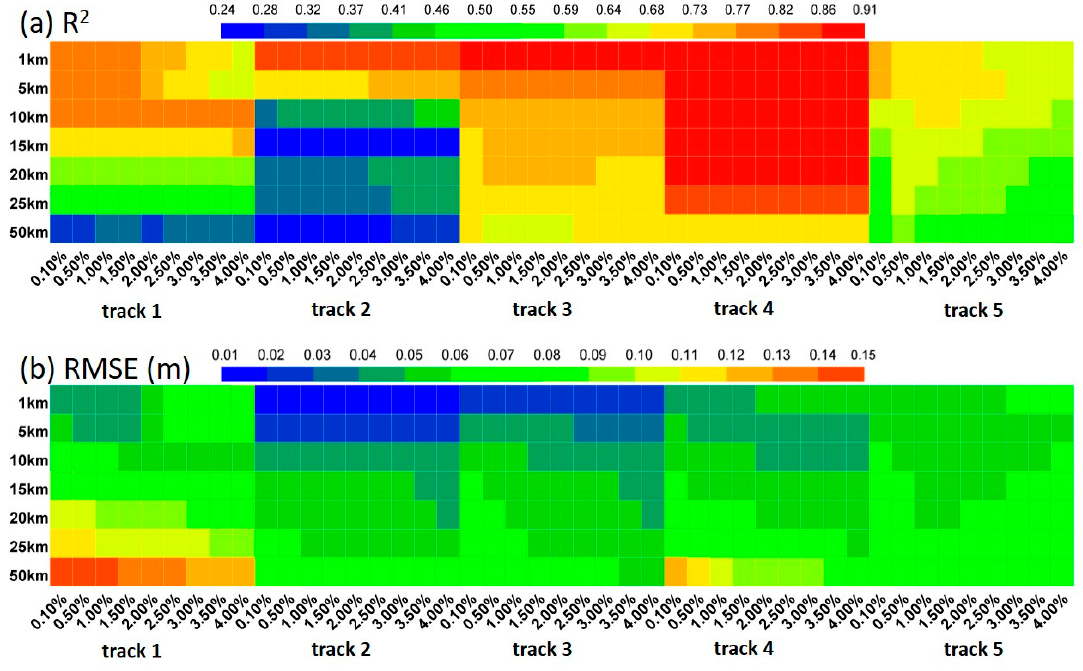
Figure 8. Coefficient of determination (R 2 ) ( a ) and root mean square error (RMSE (m)) ( b ) of all tracks between retrievals from the lowest elevation method and retrievals from the DMS method (ground truth) at 7 segment length scales: 1, 5, 10, 15, 20, 25, and 50 km, for 9 percentage scales: 0.1%, 0.5%, 1%, 1.5%, 2%, 2.5%, 3%, 3.5%, and 4% (the